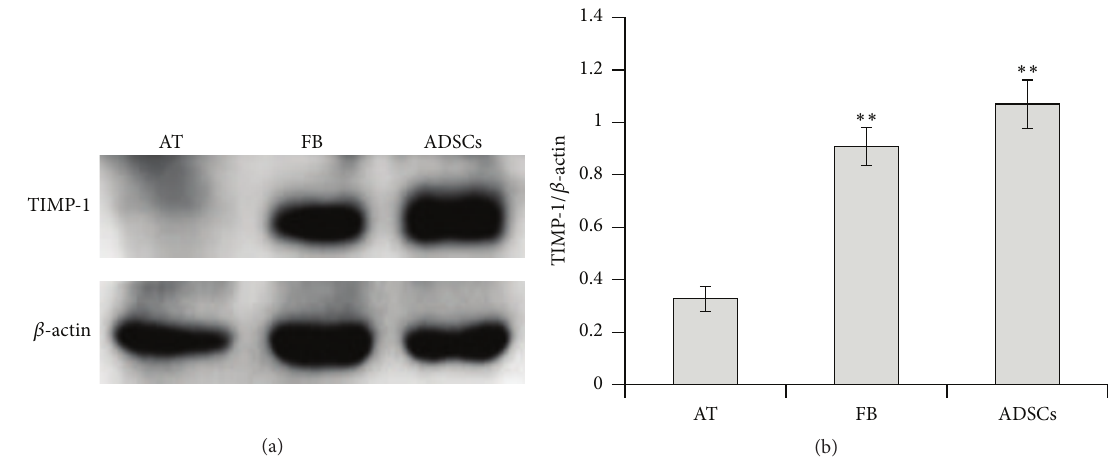
Figure 1: Western blot analysis for TIMP-1 protein expression. The expression levels of TIMP-1 protein in adipose tissue, fibroblasts, and ADSCs were determined by western blotting analysis. (a) The representative western blot images for the bands of TIMP-1. (b) Relative expression levels of TIMP-1 protein were quantified by the densitometry of each band normalized to 𝛽 -actin signal. The data represent the mean ± SD ( 𝑛 = 3 ). ∗∗ 𝑃 < 0.01 versus the AT group. AT: adipose tissue; FB: fibroblasts.